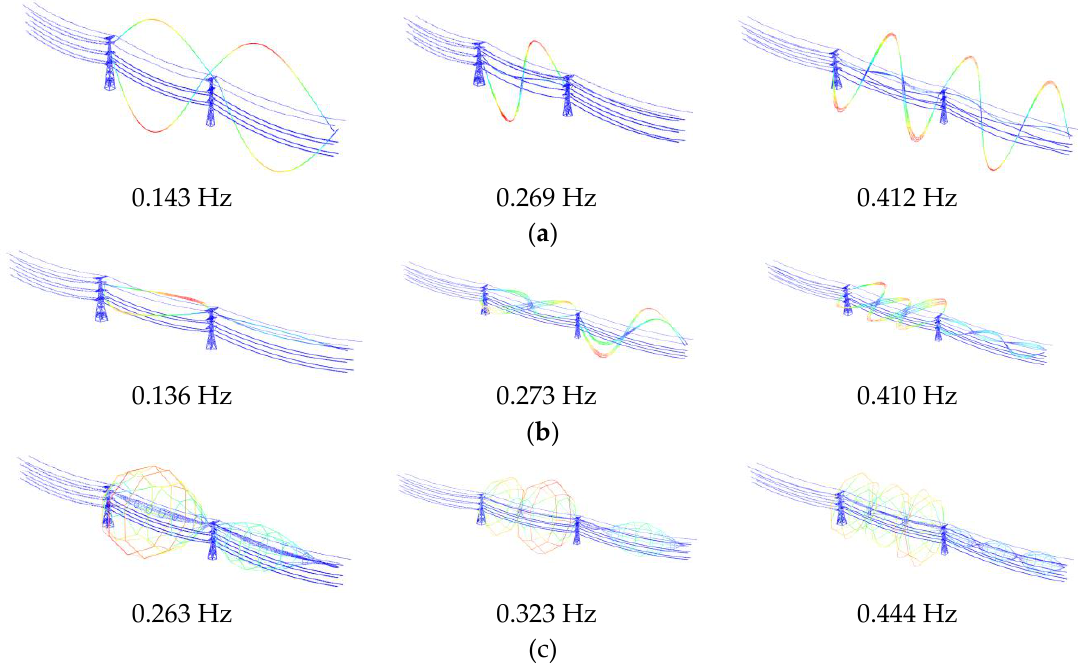
Figure 2. Low-order mode of three spans with span of 400 m iced eight-bundle conductor: ( a ) Vibration form of vertical; ( b ) Vibration form of horizontal; ( c ) Vibration form of torsional.